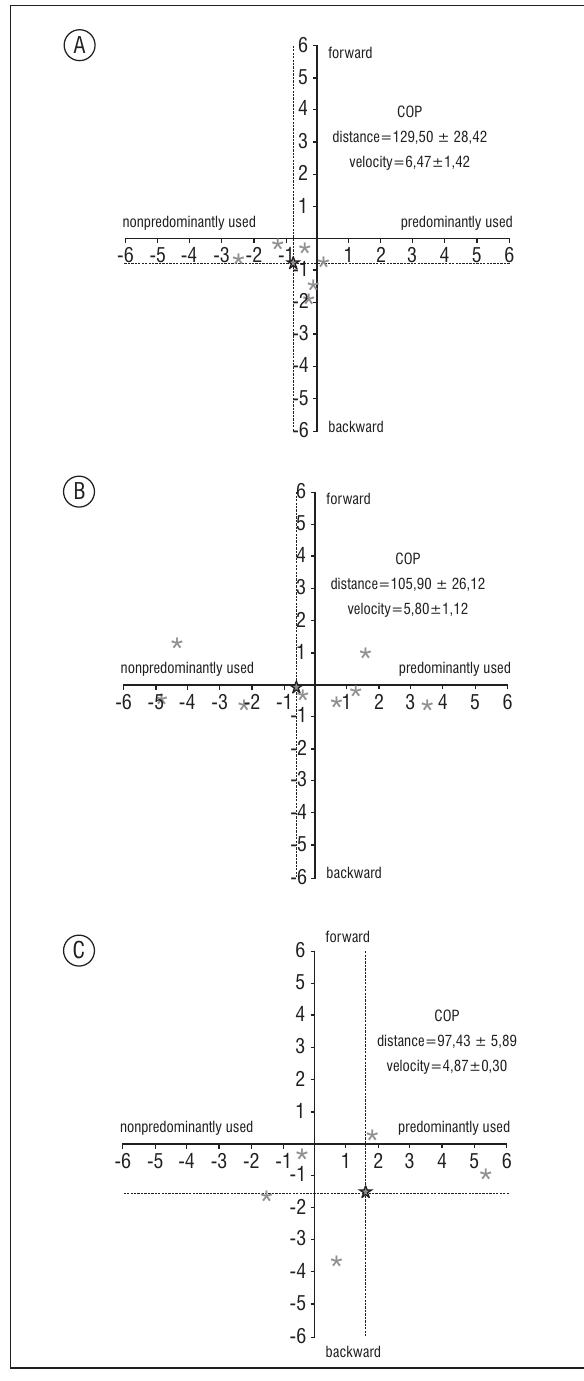
Figure 3 - Cartesian coordination systems showing individ- ual (asterisk) and group behavior (gray stars) of the Center of Pressure (CoP) displacements for hemiparesis group classified by weight-bearing distribution type: symmetric (A), asymmetric toward non-paretic side (B) and asymmetric toward paretic side (C). The mean distance and velocity were described in right upper quadrant Source: Research